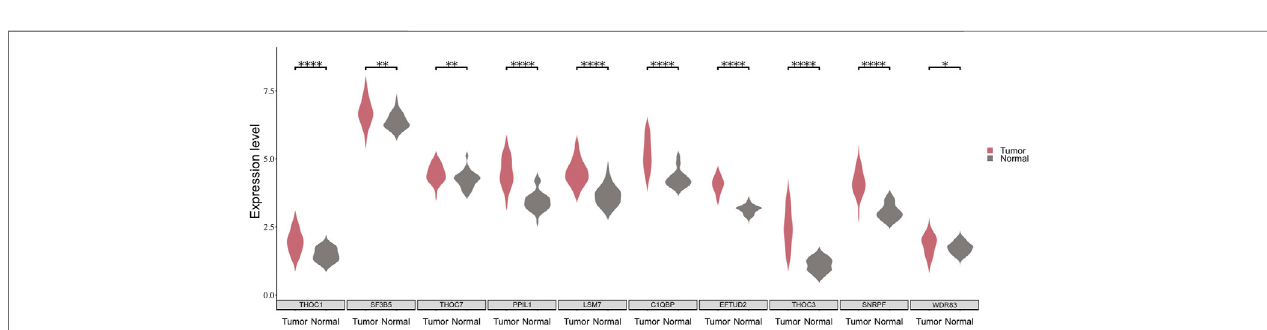
FIGURE 4 | Network diagram of the top 10 SFs and OS-ASEs. The 10 large light blue dots represent 10 SFs, the small dots represent ASEs, and the edges representsigni fi cantcorrelationsbetweenthetwodots.EdgesofdifferentcolorsrepresentassociationswithdifferentSFs.WhenanASEisassociatedwithmultipleSFs, the color of the edge is a superposition of the corresponding multiple colors. The correspondence between the factor and ASE is shown in Supplementary Table S3